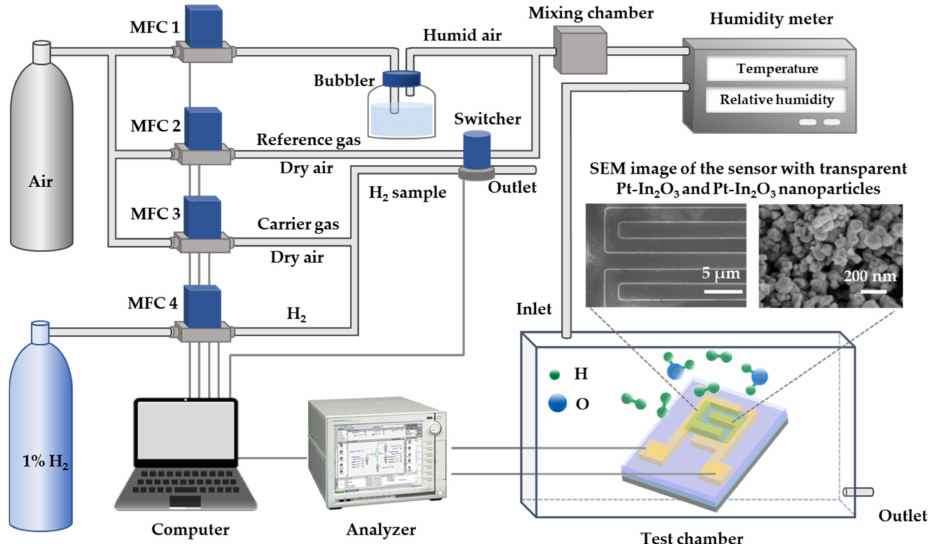
Figure 1. The experimental setup for both dry and humid H 2 detection at room